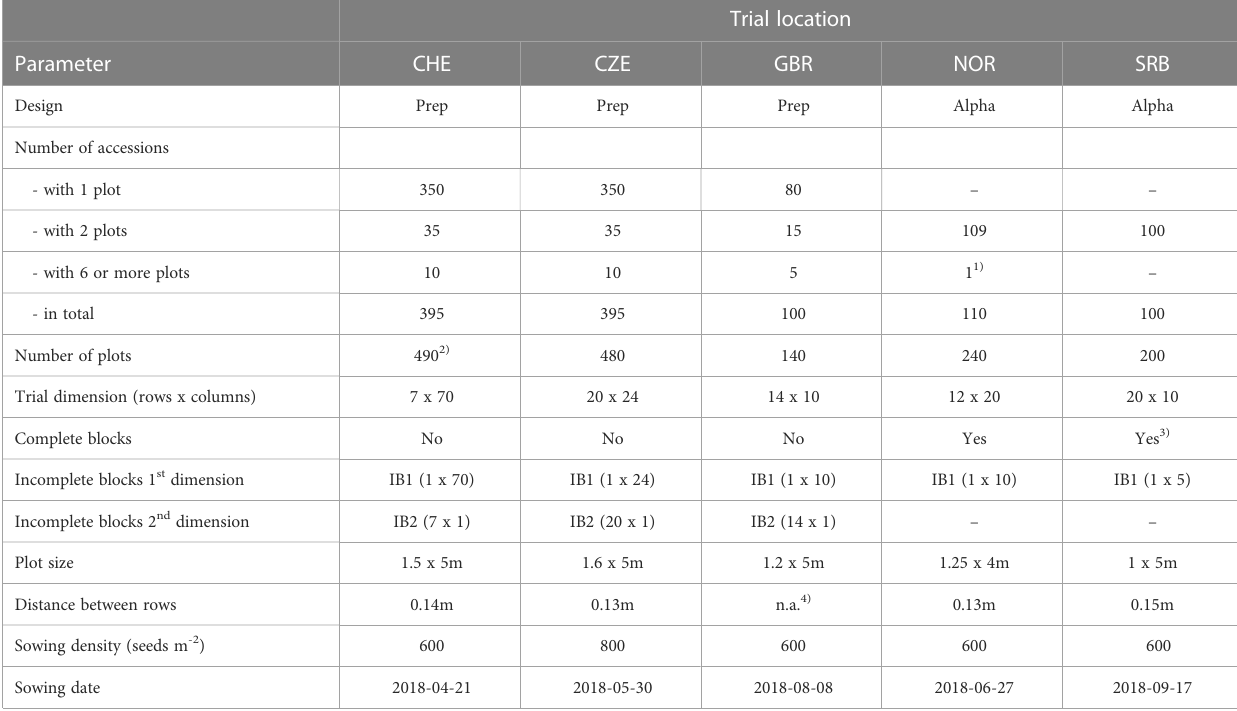
TABLE 1 Layout of fi eld trials at the different